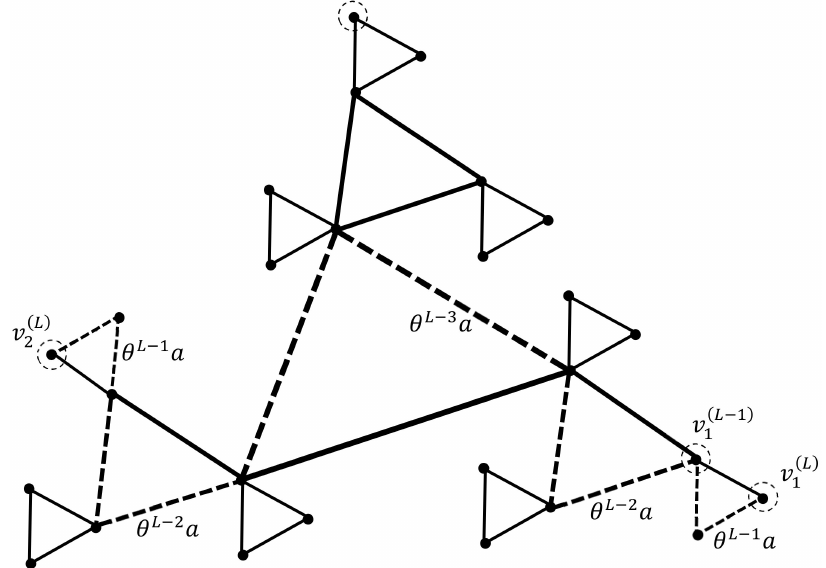
Figure 2. The shortest distance between two distant vertices on a prefractal